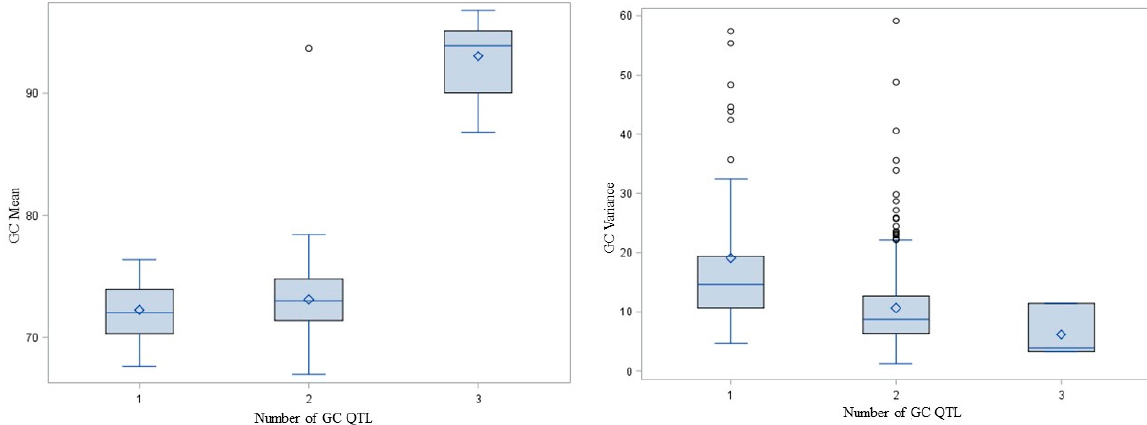
Figure 2. Box and whisker plot showing the mean, quartiles, maximum and minimum GC means and variances of CORE oat lines carrying 1, 2 or 3 copies of QTL influencing GC (Qkernel.CORE.4D, QvarGC.CORE.3D.3, QGC.TWT.CORE.Unk).